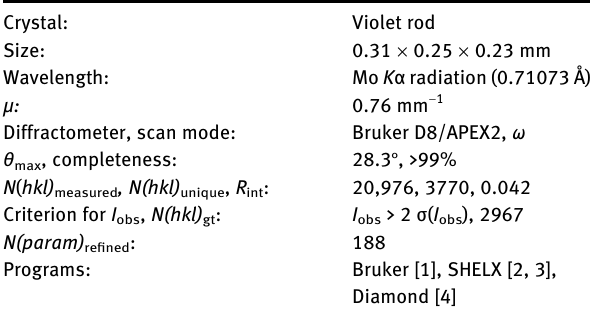
Table  : Data collection and